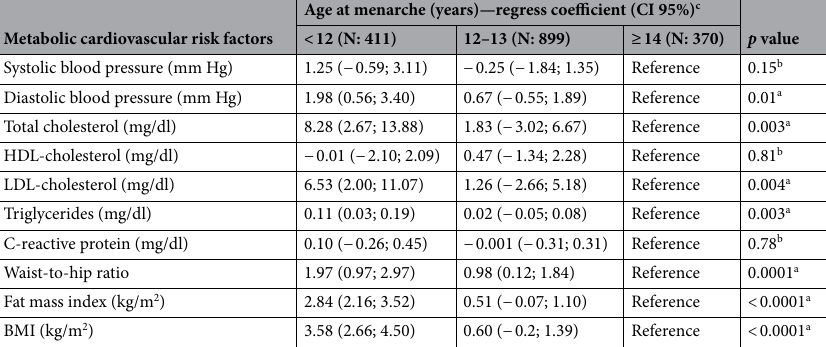
Table 3. Estimation of metabolic cardiovascular risk factors at age 30 in relation to age at menarche categories. a Linear trend test. b Heterogeneity test. c Adjusted for: family income, household score index, maternal schooling, maternal smoking, genomic ancestry, birthweight in grams and duration of breastfeeding. p value: difference in values between groups of age at menarche, p < 0.05 was statistically significant. Regress coefficients represent the unit (media or proportion) increase in the metabolic risk factor, e.g., the mean diastolic blood pressure increases, on average, 1.98 mmHg, if age at menarche was < 12 relative to those with menarche age ≥ 14